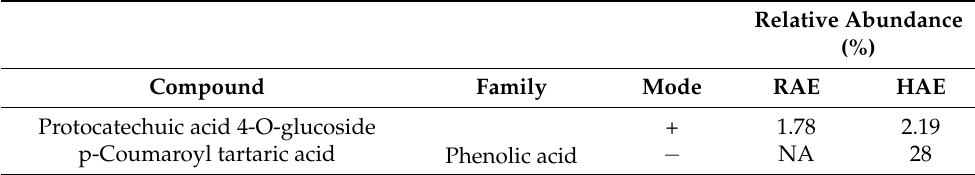
Table 3. Relative abundances of compounds in MS